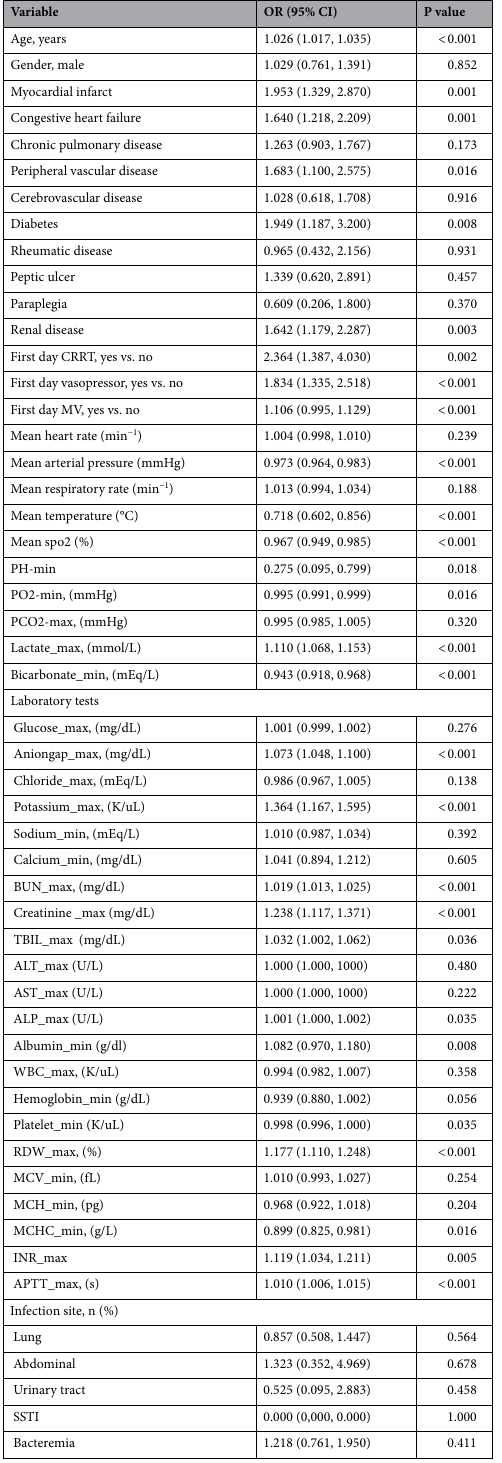
Table 2. Factors independently associated with 90-day mortality of patients with SALI by univariate logistic regression analysis in the training cohort. Categorical data are presented as frequencies (percentages), and parametric continuous data are presented as medians (interquartile ranges). SOFA score sequential organ failure assessment score, LODS score logistic organ dysfunction system score, SAPS II score simplified acute physiology II score, PH potential of hydrogen, PO2 arterial partial pressure of oxygen, PCO2 arterial blood carbon dioxide partial pressure, BUN blood urea nitrogen, Creatinine serum creatinine, TBIL total bilirubin, ALT alanine aminotransferase, AST aspartate aminotransferase, ALP alkaline phosphatase, WBC white blood cell, RDW red blood cell distribution width, MCV mean corpuscular volume, MCH mean corpuscular hemoglobin, MCHC mean corpuscular hemoglobin concentration, INR international normalized ratio, APTT partial thromboplastin time, SSTI skin and soft tissue